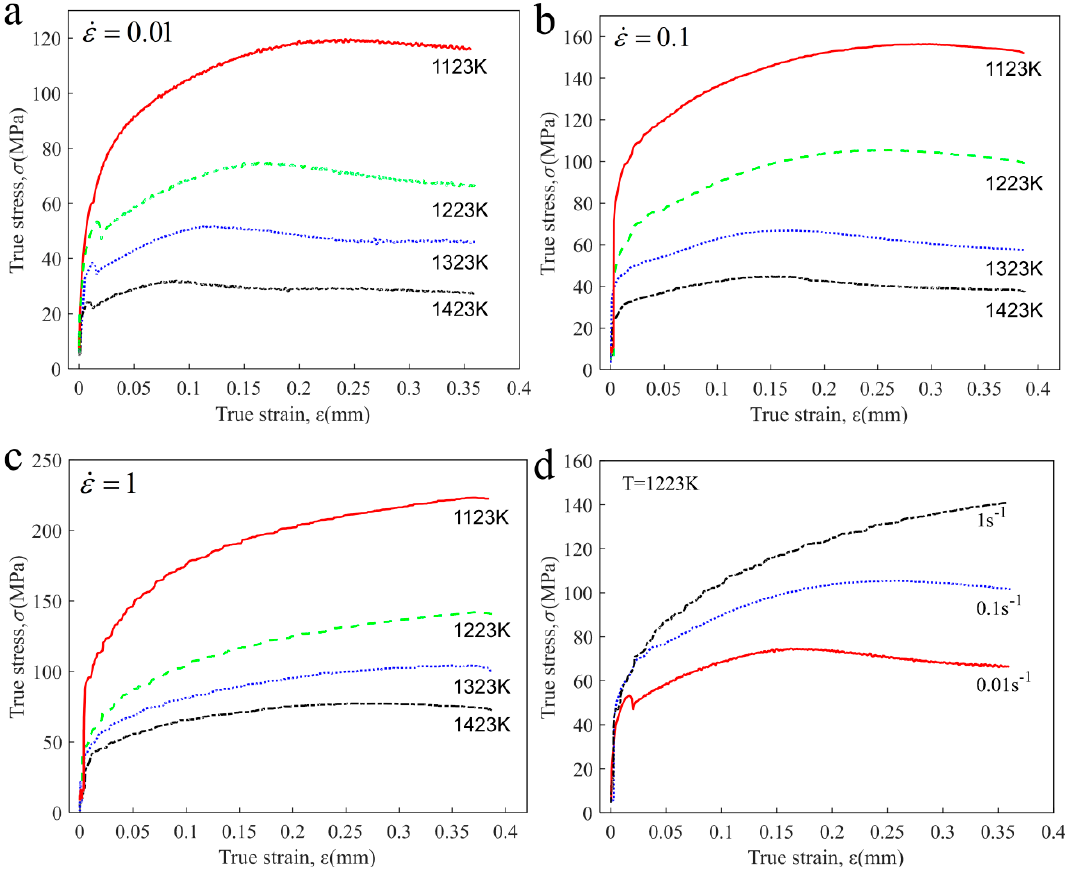
Figure 3. True stress-strain curves of 42CrMo steel at different conditions: ( a ) 𝜀 (cid:4662) = 0.01; ( b ) 𝜀 (cid:4662) = 0.1; ( c ) 𝜀 (cid:4662) = 1; ( d ) T = 1223K